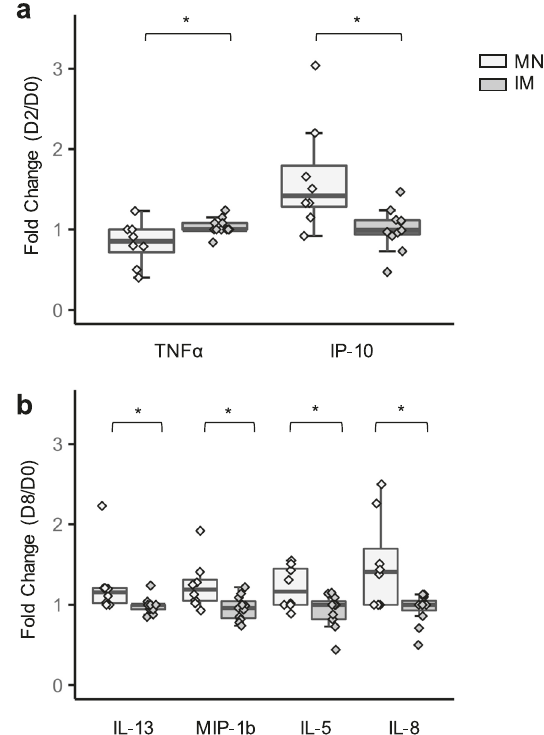
Fig. 4 Statistically signi fi cant fold changes in cytokines/chemo- kines following vaccination. Fold changes at a Day 2 and b Day 8 post vaccination by vaccine delivery group (MNP: n = 8; IM: n = 11). The proteins were detected by antibody-bound beads and quantitated using a Luminex instrument. The box portion of the plot represents the interquartile range (IQR: 25th percentile, median, and 75th percentile) of the data. Error bars represent smallest and largest values within 1.5 times IQR. Black lines indicate statistical signi fi cance based on Wilcoxon rank-sum test. * P < 0.05; ** P < 0.01. IM, IIV by intramuscular route; MNP, IIV by microneedle